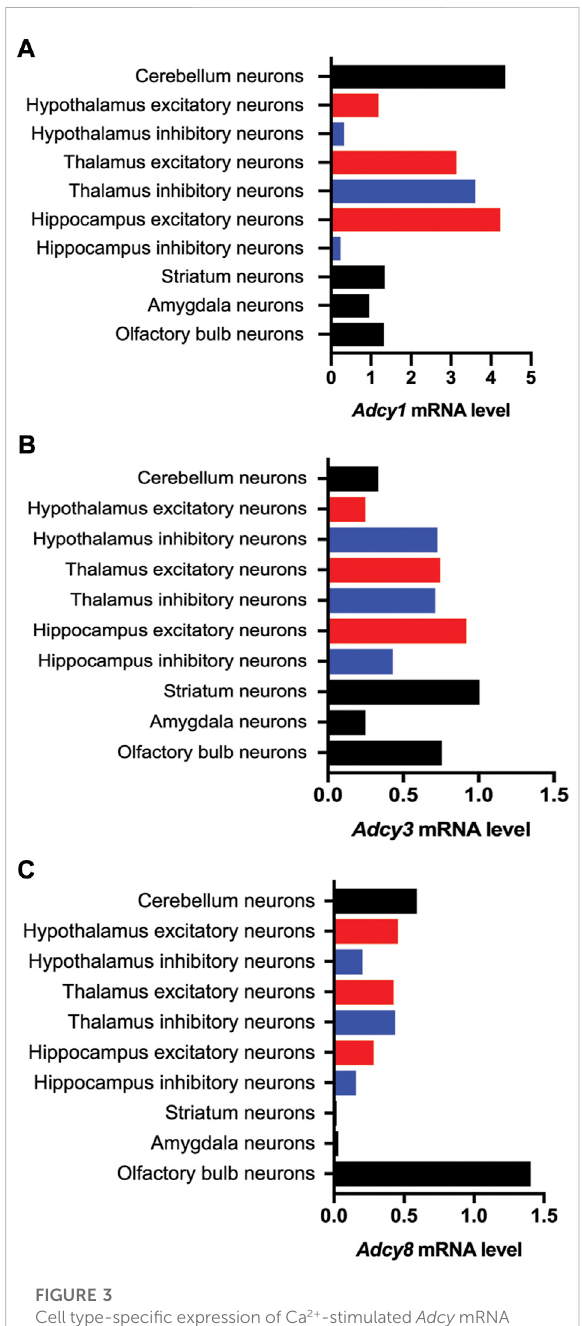
FIGURE 3 Cell type-speci fi c expression of Ca 2+ -stimulated Adcy mRNA transcripts in various regions of the mouse brain. The information of relative mRNA levels of Adcy1 (A) , Adcy3 (B) , and Adcy8 (C) in excitatoryandinhibitoryneuronsofvariousbrainregionswas collected from